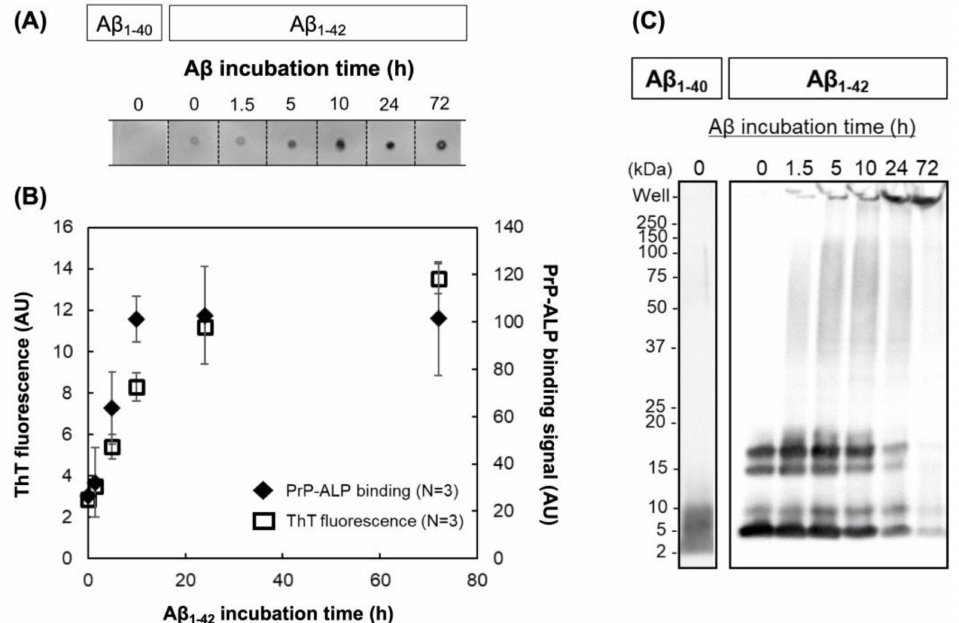
Figure 2. ( A ) Dot blotting of differently aggregated A β using PrP-ALP. The binding of PrP–ALP to A β oligomer was detected as the chemiluminescent signal generated from catalytic reaction of PrP–ALP. ( B ) Relationship between the PrP–ALP binding signals (closed diamond) and the ThT fluorescence (open square) from A β 1–42 . The data are shown as the mean ± SD in the graph ( n = 3). ( C ) Western blot analysis of differently aggregated A β using anti-A β antibody,